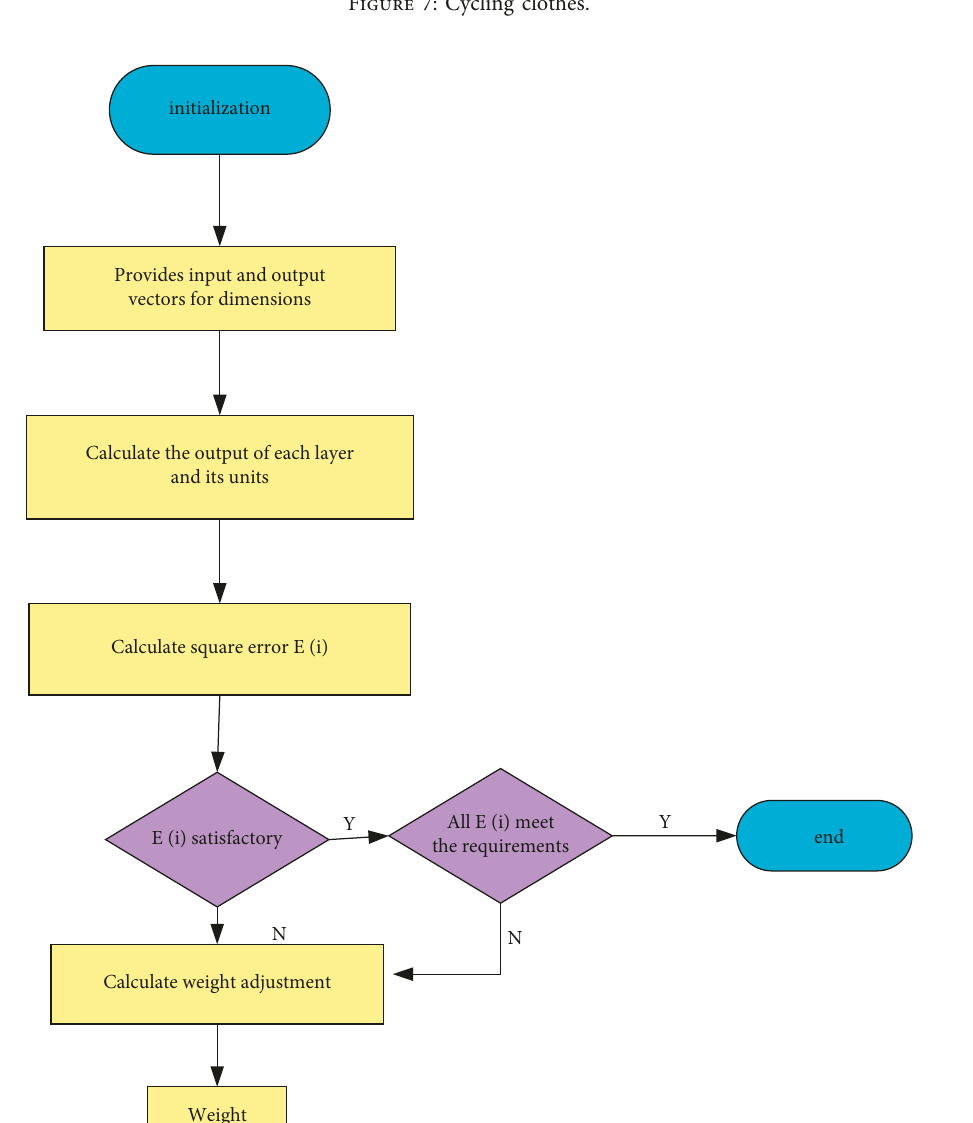
Figure 7: Cycling